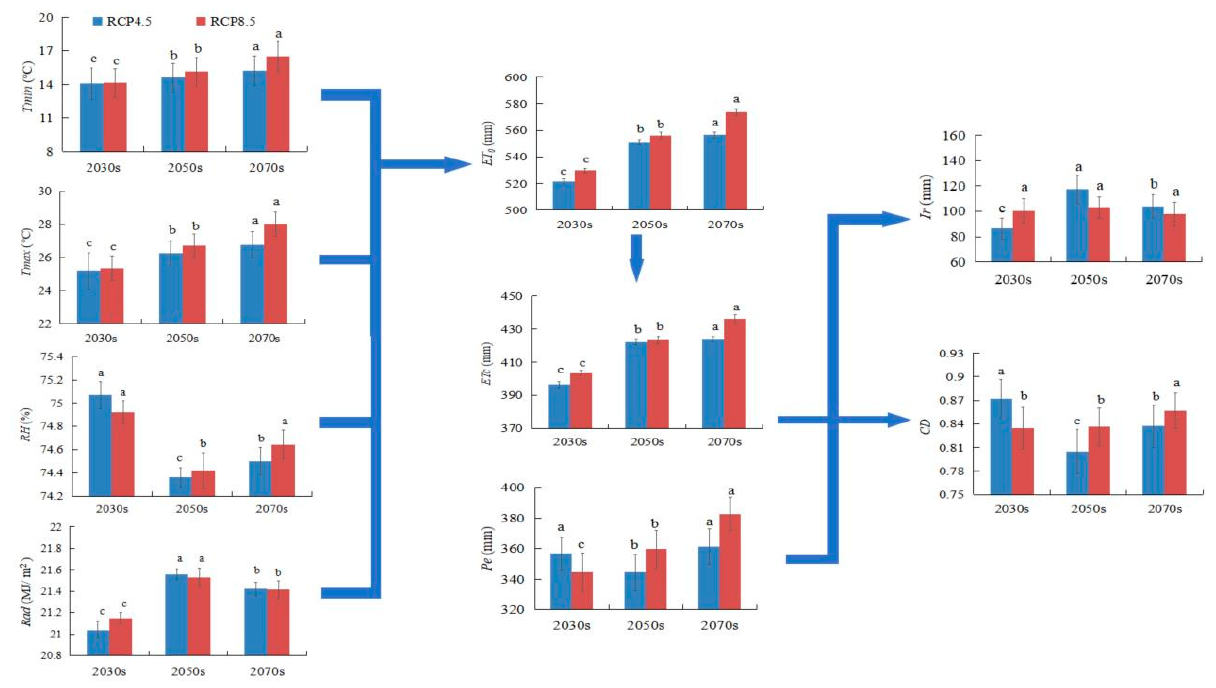
Figure 14. Effects of changes in meteorological factors on soybean ET c and the relationships among P e , ET c , and I r under RCP4.5 and RCP8.5 for 2021–2080. Bars marked with different lowercase letters indicate significant differences between groups ( p < 0.05), while those marked with the same lowercase letters indicate insignificant differences between groups ( p > 0.05).